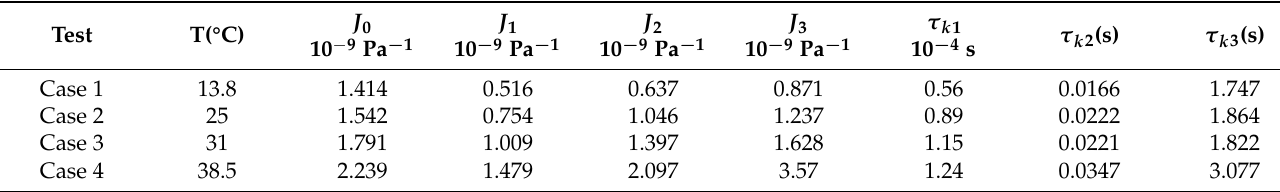
Table 2. Creep function coefficients in different cases